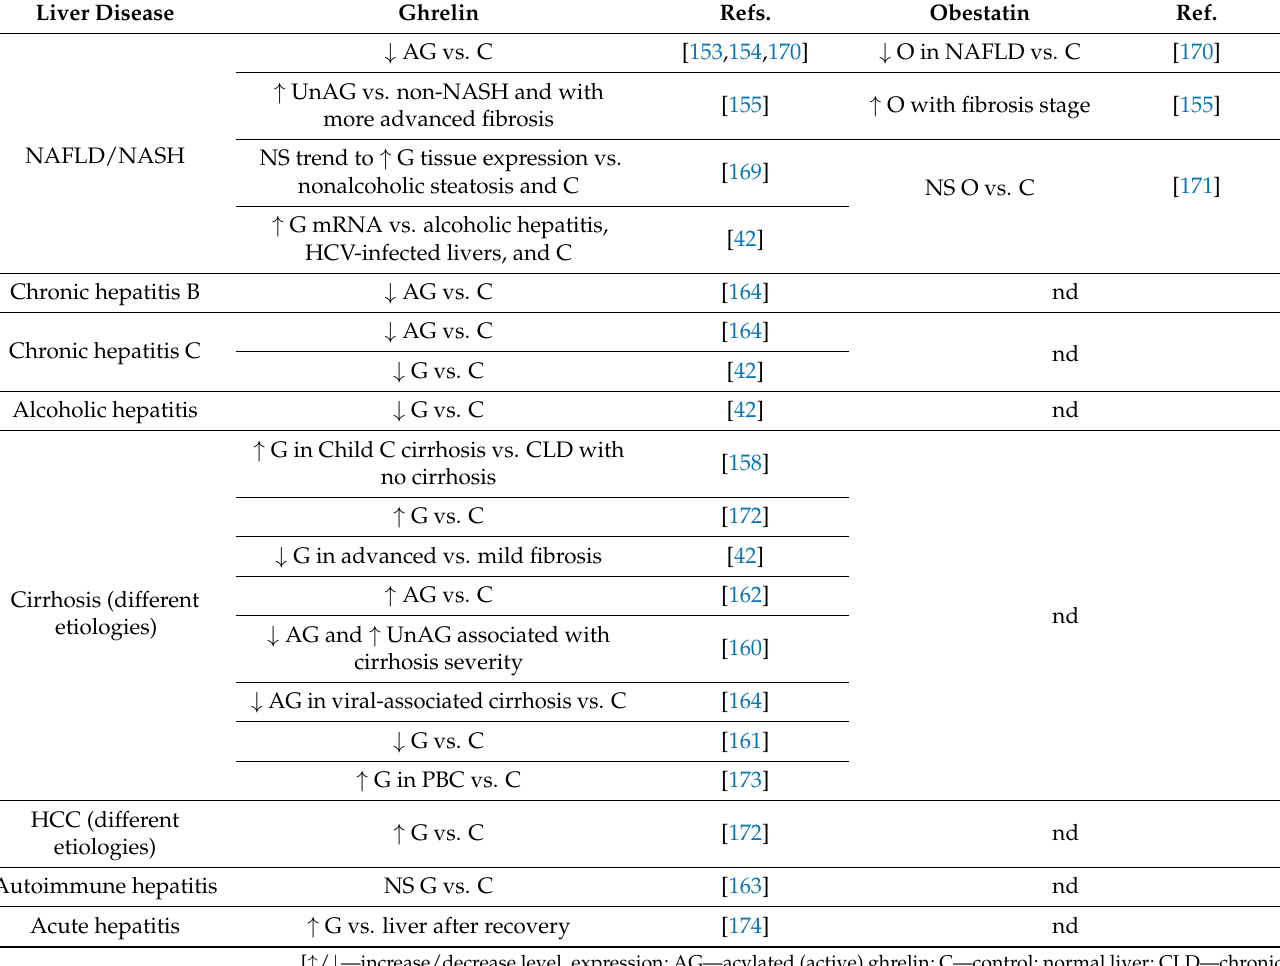
Table 3. Serum Levels/Tissue Expression of Ghrelin and Obestatin in the Most Common Human Liver